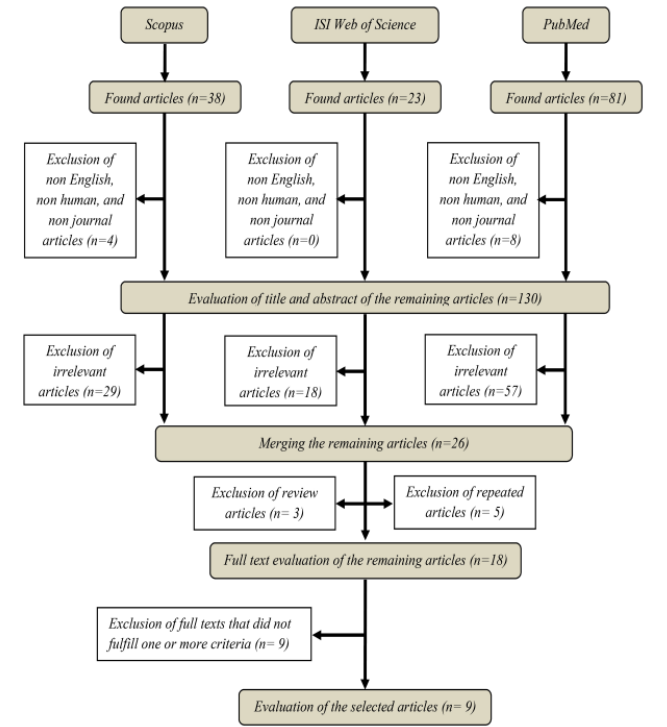
Figure 1. The procedure for selection of studies from three